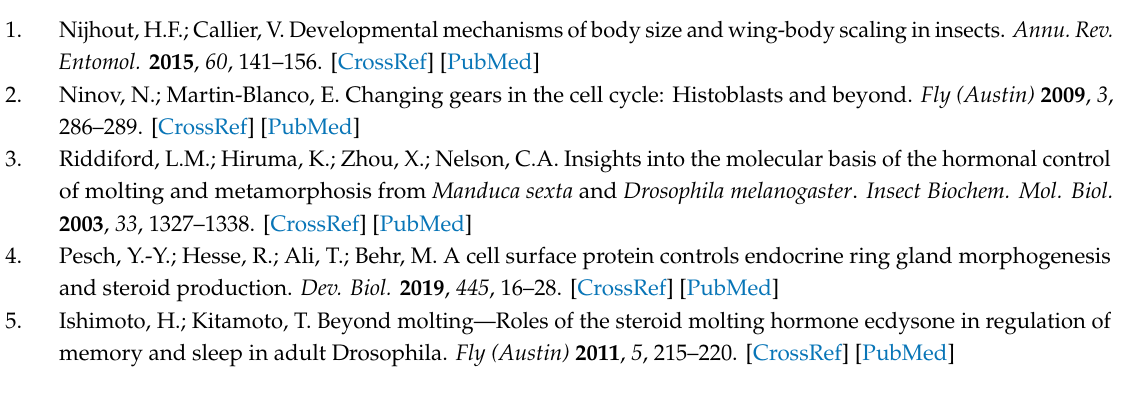
Figure S1. 20E regulates BmFoxO nuclear translocation in BmN-SWU1 cells. (A) BmFoxO translocates to the nucleus after 20E induction in TC100 medium with 10% FBS. Cells were incubated with 0.25 µ g / mL 20E for 6 h. Cells incubated with the same amount of DMSO for 6 h were treated as a control. Red fluorescence indicates the BmFoxO protein with HA tag. Blue, nuclei (Hoechst 33342). Scale bars, 10 µ m. (B) Statistical analysis of the percentage of BmFoxO positive cells with nuclear distribution in A (* p < 0.05, ** p < 0.01). (C) After 48 h of transfection with the pIZ- BmFoxO plasmids, BmN-SWU1 cells were incubated with 0.25 µ g / mL 20E or the same amount of DMSO for another 6 h. Then, the cytoplasmic and nuclear proteins were separated and detected by Western blotting. W represents whole cell lysates, C indicates the cytoplasmic proteins, and N shows the nuclear proteins. BmFoxO protein fused with HA tag was detected by HA antibody. In addition, α -tubulin was employed as the internal reference for cytoplasmic proteins and PCNA was used as the internal reference for nuclear proteins. (D) Statistical analysis of the relative proportion of nucleus distributed BmFoxO proteins after 0.25 µ g / mL 20E incubation for 6 h (* p < 0.05, ** p < 0.01). Figure S2. (A) CRISPR / Cas9 vector construction. (B) DNA sequencing analysis of the CRISPR / Cas9 target sites in BmFoxO and BmEcR genes. The BmFoxO and BmEcR sequences of WT are shown at the top. The target sequence of sgRNA is indicated in blue. Deletions are indicated by dashes. The mutated bases are shown in red. (C) The nucleotide sequence (NM_001202535) and deduced amino acid sequence (NP_001189464.1) of the BmFoxO gene. The Forkhead domain is shown in yellow background. The FOXO-TAD domain is shown in cyan